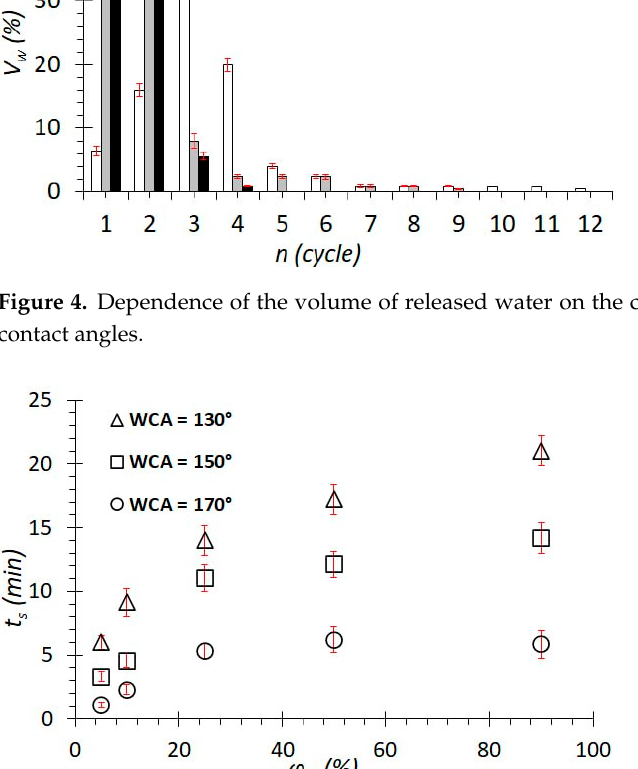
Figure 4. Dependence of the volume of released water on the cycle number for different wetting contact angles.